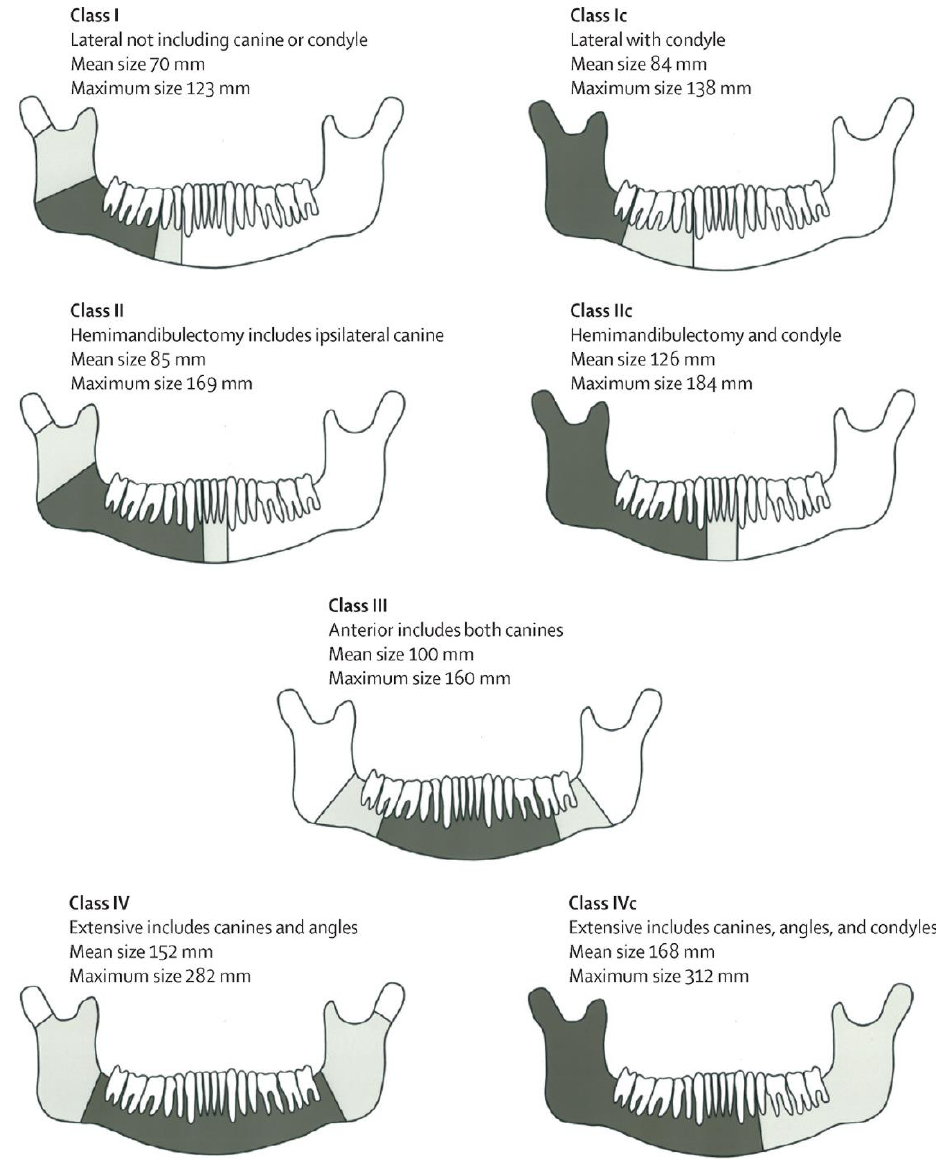
Figure 2. Proposed classification of mandibular defects. Mean defect size (dark shading); total extent of mandibular defect (light shading). Reprinted with permission from Elsevier [30].